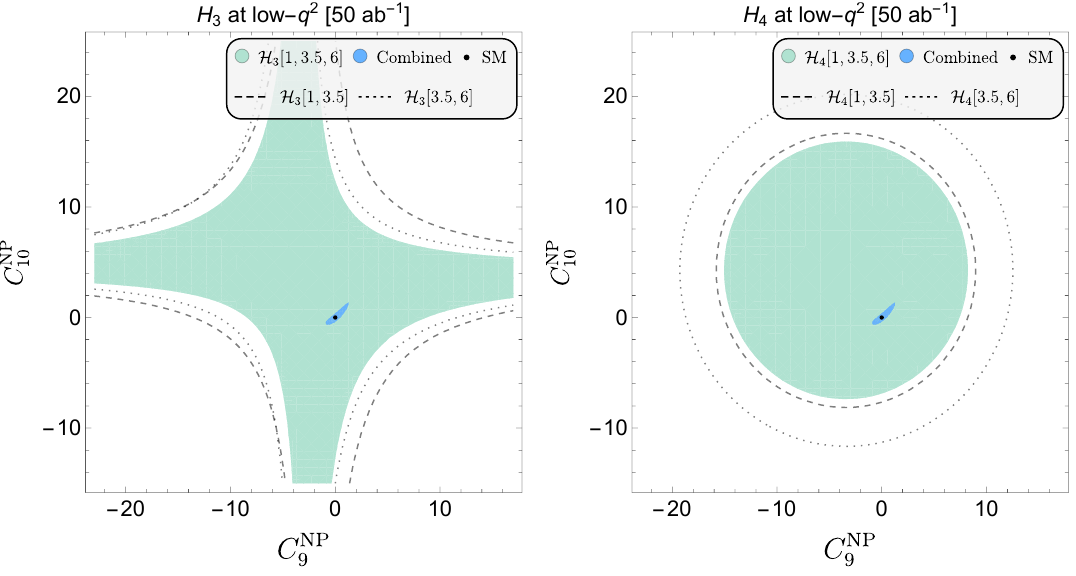
Figure 5 . Projected constraints from the QED observables H 3 and H 4 at low- q 2 . See the caption in (cid:12)gure 2 for further